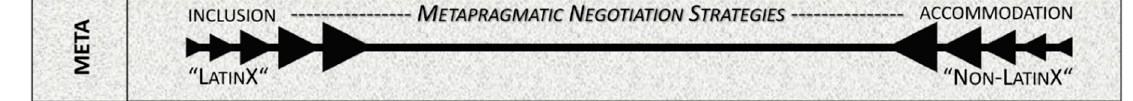
Figure 2. Metapragmatic Negotiation Strategies: Inclusion and Accommodation.